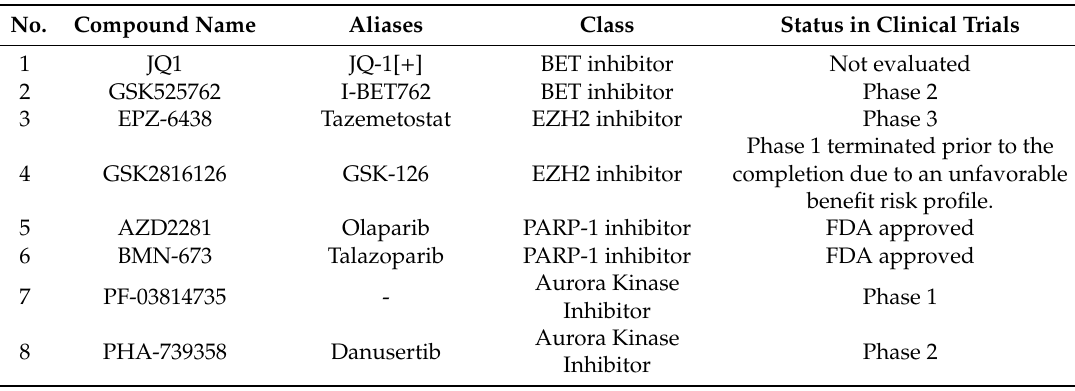
Table 2. Compounds used in drug screenings